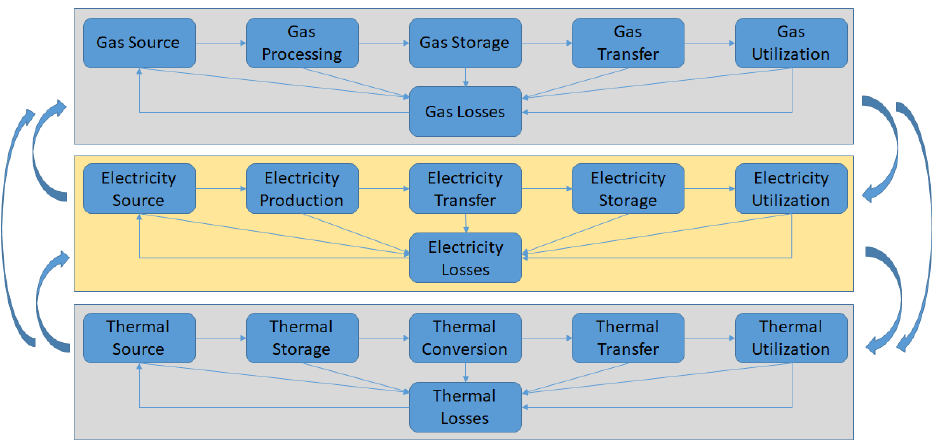
Figure 2. Proposed modeling of hybrid electricity–thermal–gas interconnected systems.